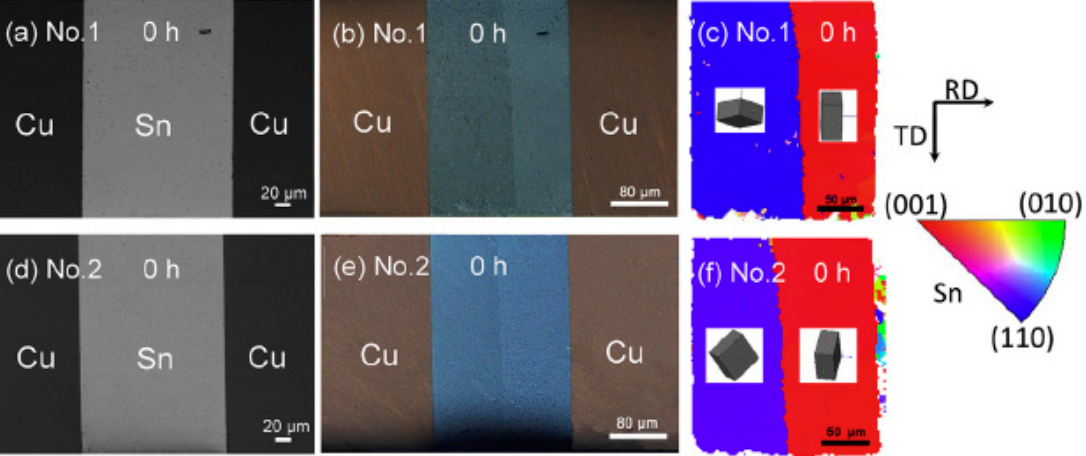
Figure 4. Cross-sectional microstructure of the as-soldered ( a , d ) back-scattered SEM images, ( b , e ) cross-polarized images, and ( c , f ) EBSD inverse pole figure orientation image map Reprinted with permission from Ref. [48] Copyright 2016 Elsevier.